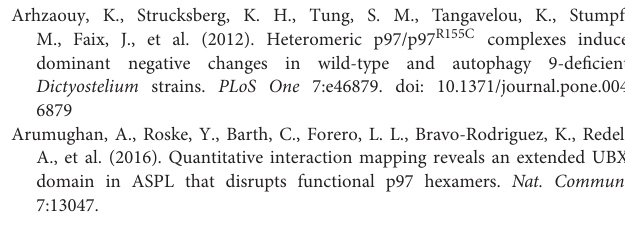
Supplementary Figure 1 | Structure-based amino acid sequence alignment of human ASPL (UBXD9) and D. discoideum UBXD9. Secondary structure elements are color mapped; ( α -helices: green, β -strands: red; cysteine residues: yellow). The UBL domain, the UBX domain, the helical lariat and the coiled coil (CC) regions are indicated by rectangles above and below the sequence alignment. Potential coiled coil motifs were predicted using MultiCoil (Wolf et al., 1997). The conserved aspartate (D) of the helical lariat and the double proline (PP) motif are boxed. Amino acid positions indicated in blue above and below the amino acid sequences denote the limits of various experimental constructs. Genbank accession numbers are XP_641771 for D. discoideum and NP_076988 for human UBXD9. Supplementary Figure 2 | Pull-down experiments with recombinant p97 and full-length or truncated GST-UBXD9 coupled to glutathione beads. GST coupled to glutathione beads was used as negative control. Representative SDS PAGE gels stained with Coomassie Blue. The position of p97 is indicated. *Positions of GST and of full-length UBXD9 and UBXD9 truncation constructs tagged with GST. Supplementary Figure 3 | UBXD9 and UBXD9 261 − 573 reduce the ATPase activity of p97. Data is presented as relative ATPase activity, mean values and SD of three experiments. For statistical analysis, the Dunnett’s multiple comparison test, implemented in GraphPad Prism as post hoc analysis, was performed. *** p ≤ 0.001. Supplementary Figure 4 | Analysis of IP experiments and proximity labeling proteomics. (A) GFP trap experiments with the soluble proteins from total cell lysates of AX2 cells expressing GFP, UBXD9-GFP, or GFP-UBXD9. Top: SDS-PAGE and silver stain of proteins bound to the beads (Pellet). *Indicates the position of GFP-UBXD9 and # of GFP. + Indicates the position of the absent UBXD9-GFP silver band and of the visible UBXD9-GFP immunoblot band (see Western Blot). Bottom: Western blotting of proteins bound to the beads (Pellet). Endogenous UBXD9 of 95 kDa and GFP-tagged UBXD9 of 120 kDa were detected with the polyclonal UBX23520 antibody. *Indicates the position of GFP-tagged UBXD9 and o of untagged UBXD9. (B) BioID experiments with soluble proteins from total cell lysates of AX2 and AX2/BirA-UBXD9 cells. Top: SDS-PAGE and silver stain of soluble proteins before (S 1 ) and after (S 2 ) incubation with streptavidin sepharose beads and proteins bound to the beads (Pellet). The position of BirA-UBXD9 is indicated. Bottom: Western blotting of soluble proteins after (S 2 ) incubation with streptavidin sepharose beads and of proteins bound to the beads (Pellet). Endogenous UBXD9 and BirA-tagged UBXD9 were